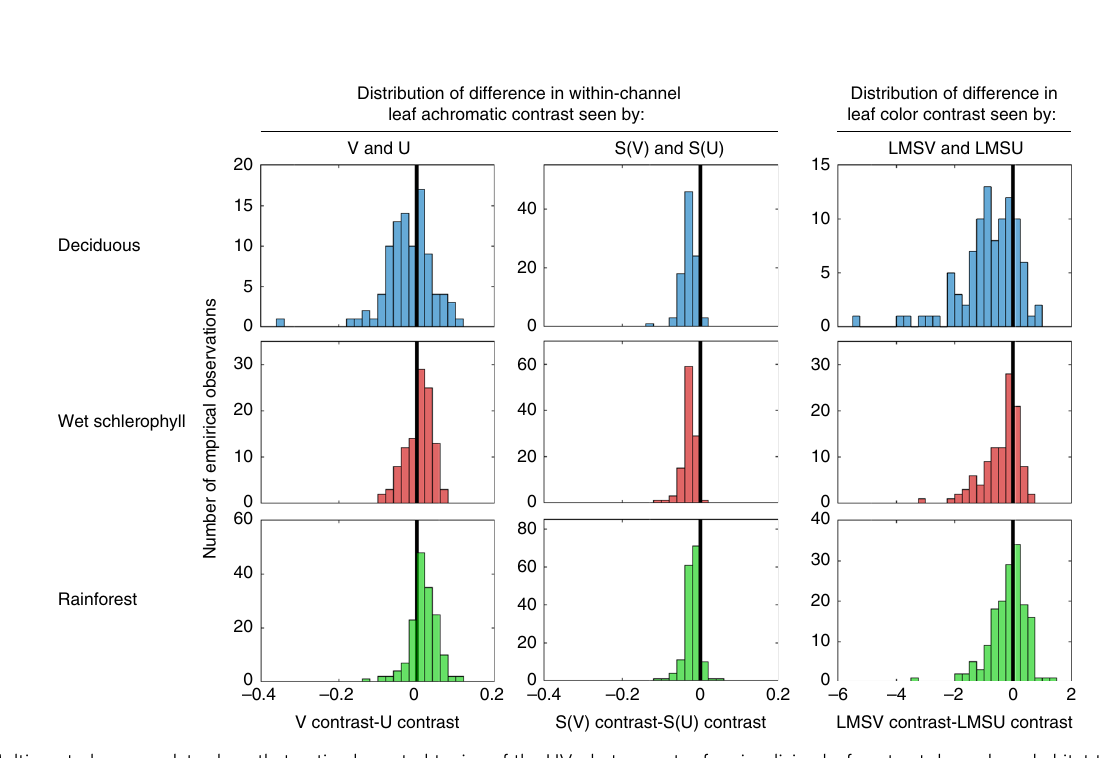
Fig. 6 Multispectral camera data show that optimal spectral tuning of the UV-photoreceptor for visualizing leaf contrast depends on habitat type. Each of the left panels shows the distribution of the difference in within-channel leaf-contrast seen by the two UV-cone variants in a different habitat. The middle panels show the same distribution types for the two S-cone variants. The right panels show the same distribution types for color contrasts seen by LMSV and LMSU tetrachromats. The heavy vertical black line at x = 0 indicates the point at which the two variants see equal contrast. The V-cone was advantageous for visualizing leaf achromatic contrast in rainforest ( P < 0.0001) and wet schlerophyll ( P = 0.004) habitats, and the S(U)-cone was